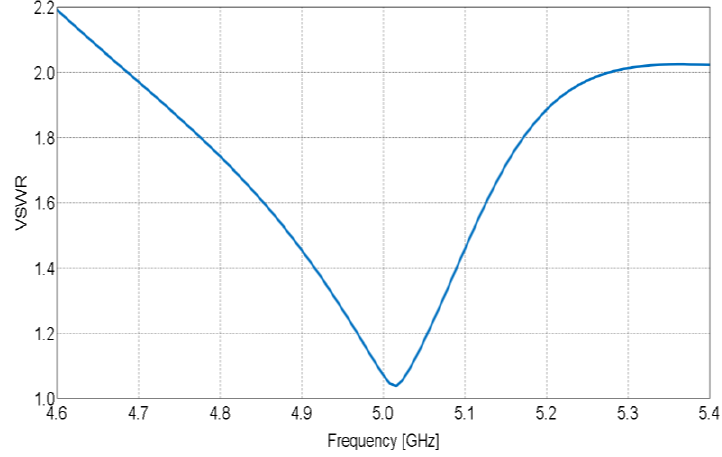
Fig. 5. Single radiator standing wave ratio frequency dependence.